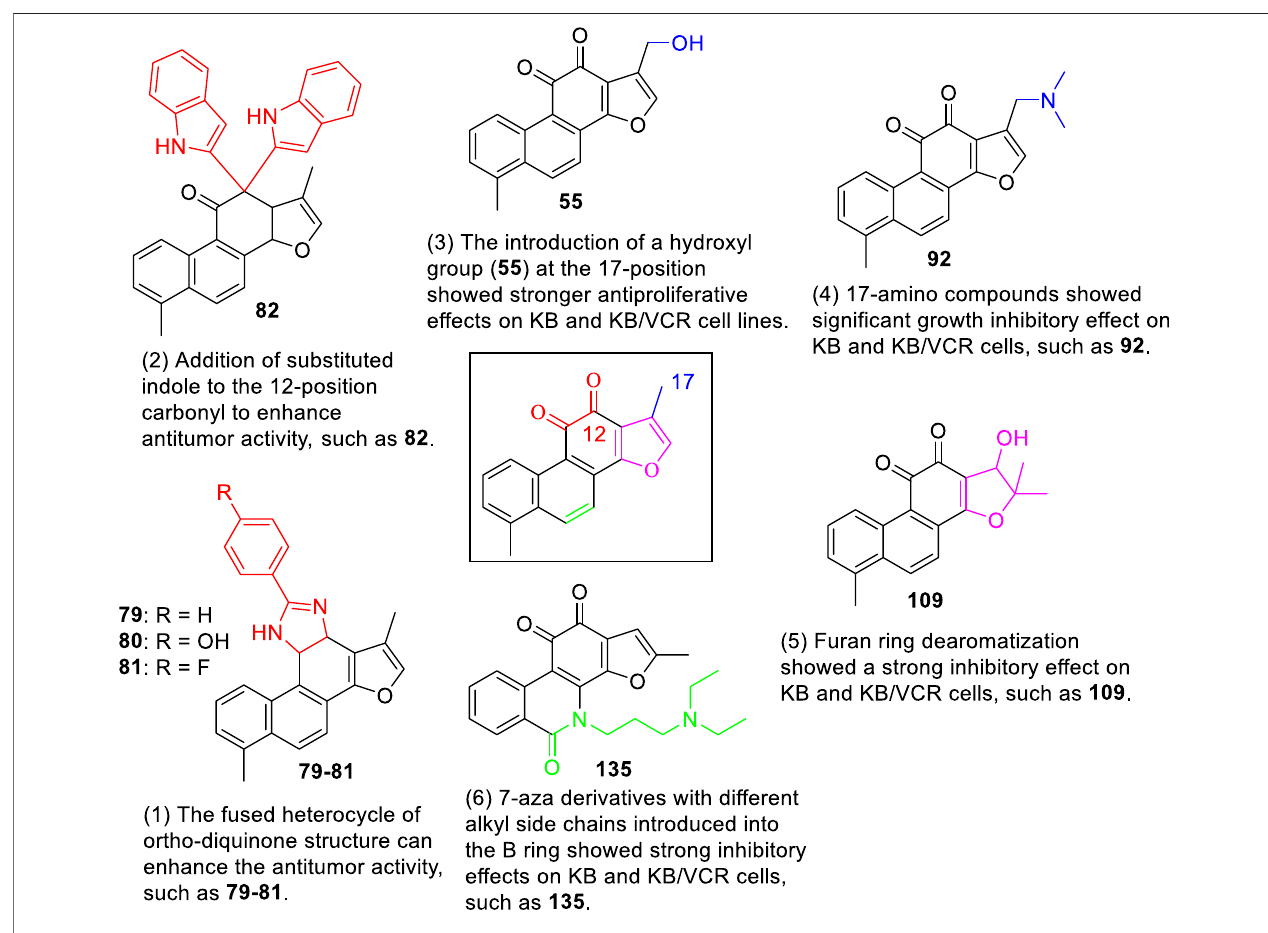
FIGURE 17 | Graphical depiction of the general structural anticancer activity relationship of tanshinone I derivatives.